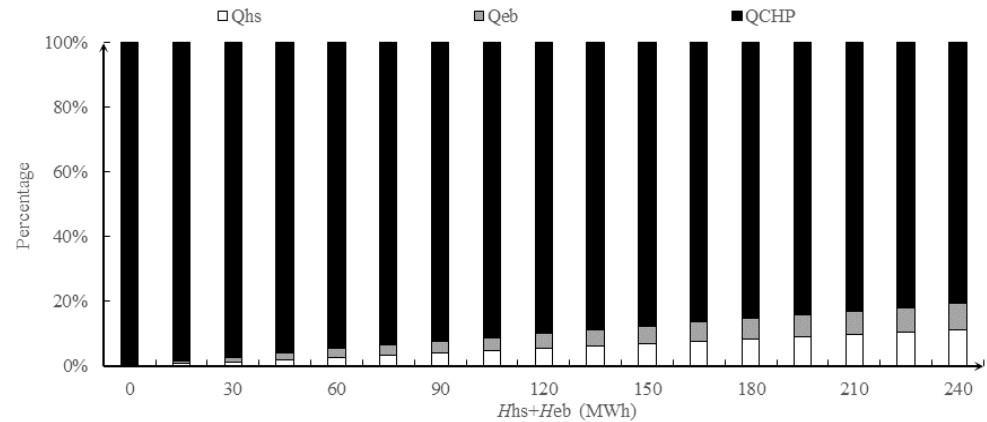
Figure 15. The proportion of heat source during the TED working